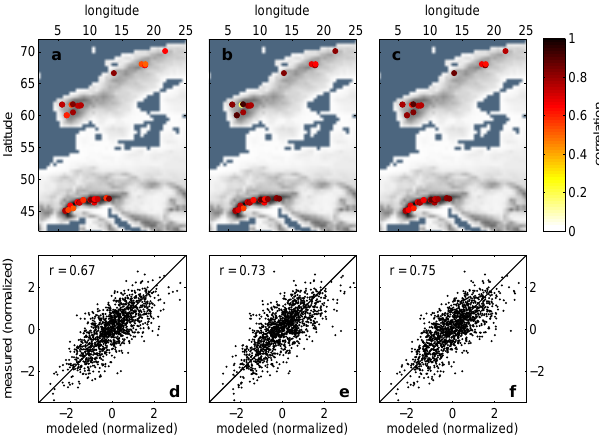
Fig. 4. Upper row: correlation coefficients of the individually trained (a) , mean (b) , and climatologically derived model (c) for all glaciers with more than 12 measured annual mass balances. See Tables 1 (for a and b ) and 2 (for c ) for the mean values and standard deviation. Gray background shading: topography of the CRU TS 3.0 data. Lower row: modelled versus measured normalized annual mass balances of the individually trained model (d) and the mean model (e) obtained by cross validation, and of the climatologically derived model (f) , for all glaciers with more than 12 measured mass balances.